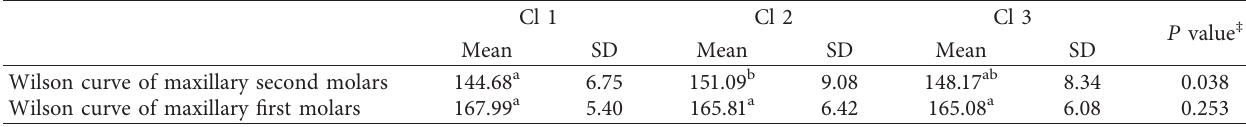
Table 3: Comparison of the curve of Wilson among the three sagittal skeletal patterns.